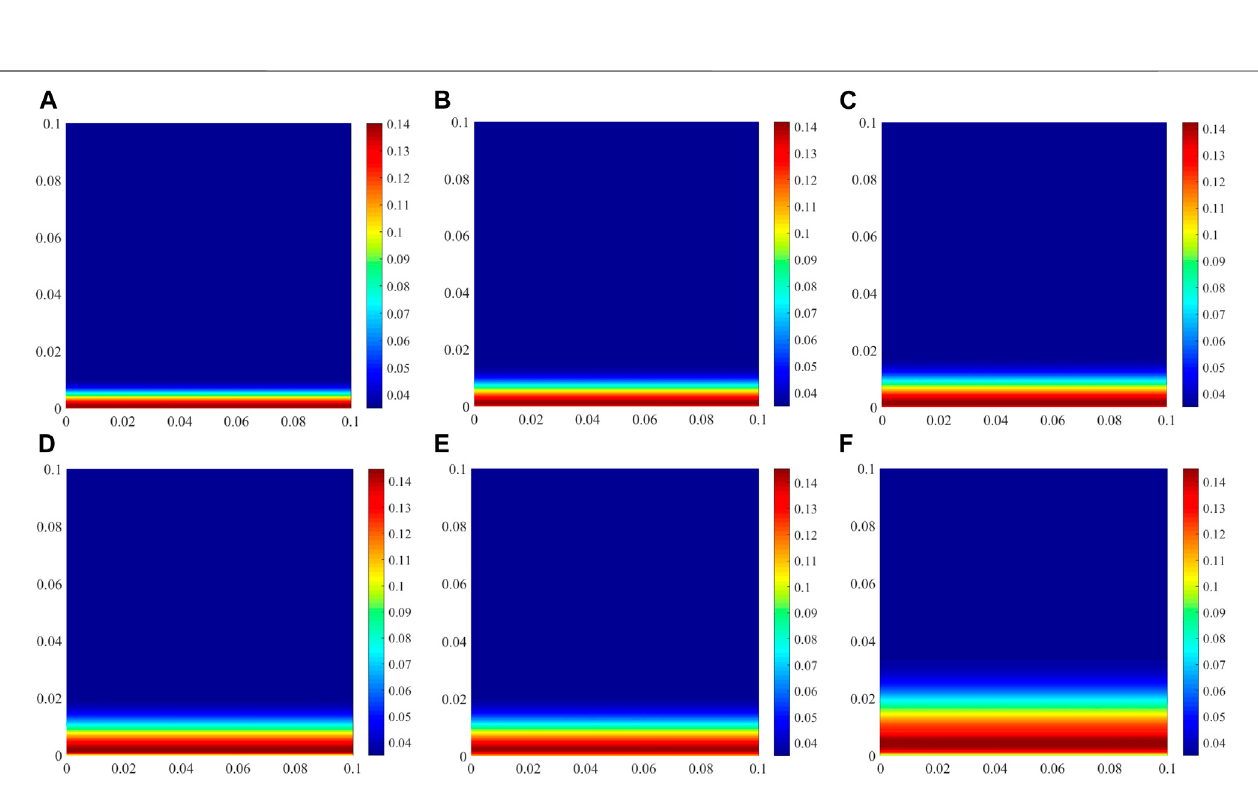
Frontiers in Materials |